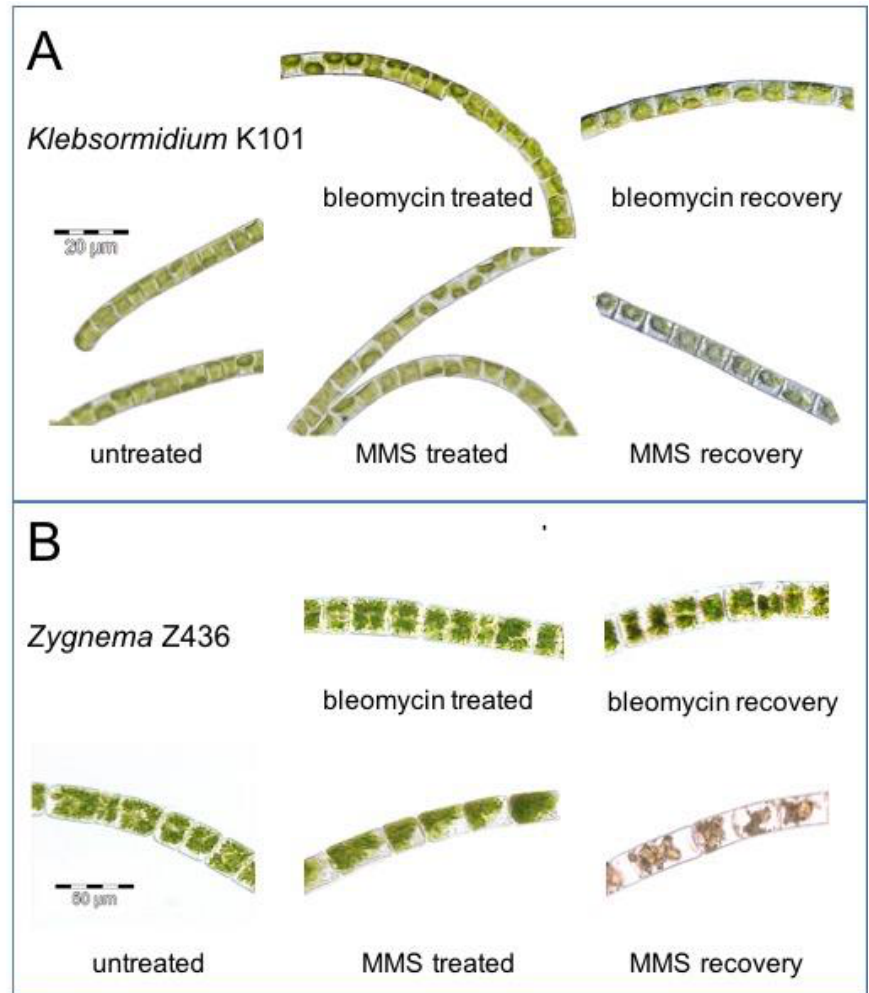
Figure 3. Effect of genotoxic treatment on morphology of algal cells. The suspension cultures of K. flaccidum K101 ( A ) and Zygnema sp. Z436 ( B ) in bold basal medium (BBM) were treated 30 min